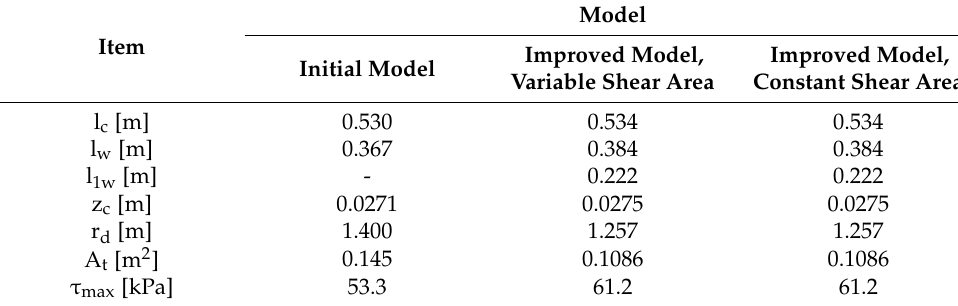
Table 3. Parameters for tire–ground interaction.